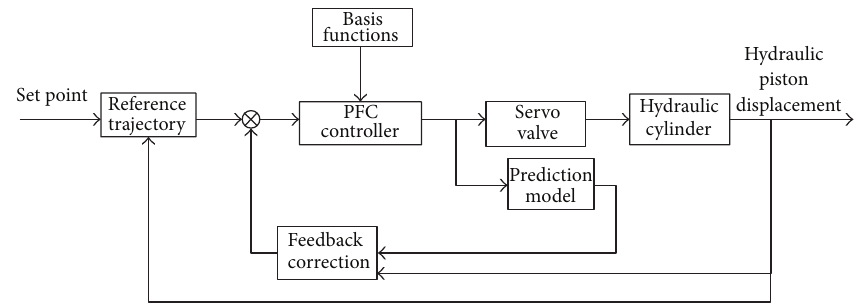
Figure 1: Block scheme of predictive function control